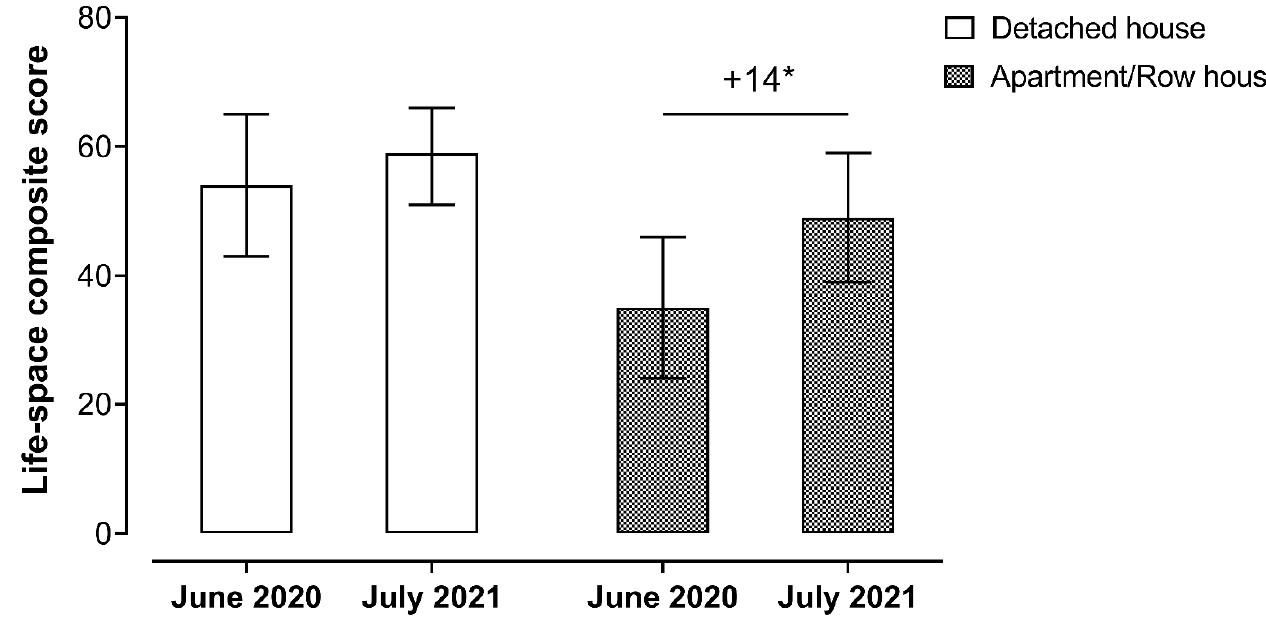
Figure 1. Life-space mobility composite score before and after COVID-19 vaccination among 32 older adults with hypertension residing in a detached house ( n = 17) or apartment/row housing ( n = 15). Values are expressed as mean and its 95% Wald confidence interval. The models were analyzed using a generalized linear model. * p < 0.05.